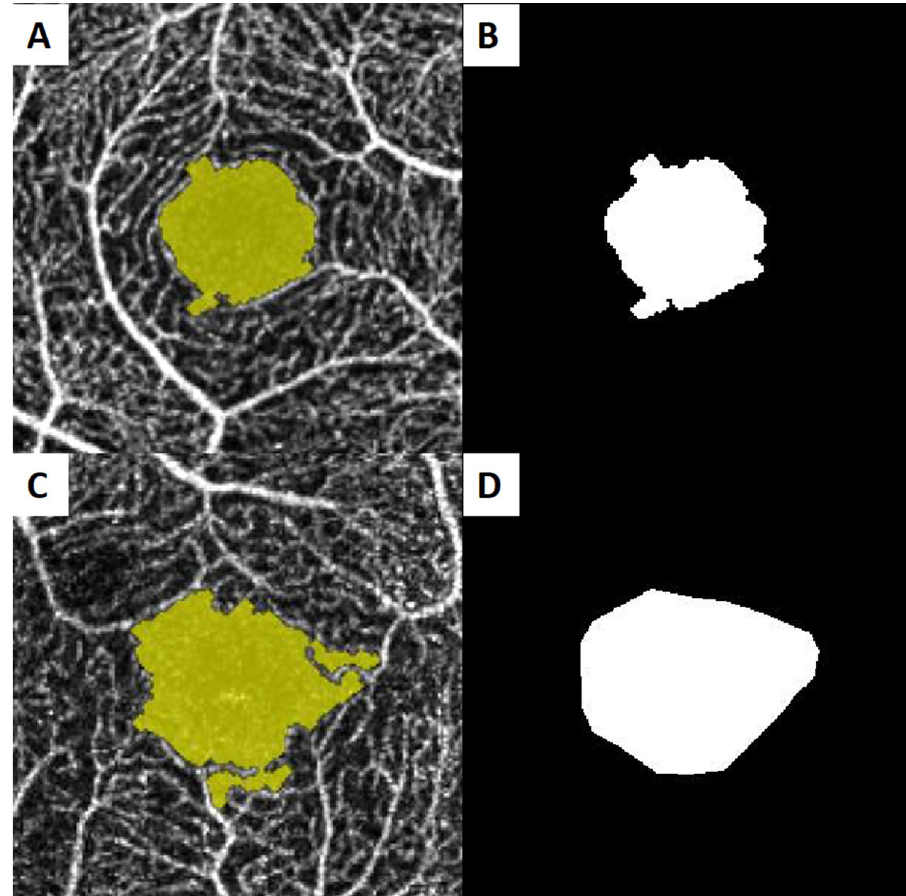
Figure 2. ( A , B ) Optical coherence tomography angiogram of the foveal avascular zone (FAZ) of non-high myopia in superficial layer. ( C , D ) Optical coherence tomography angiogram of the FAZ of high myopia in superficial